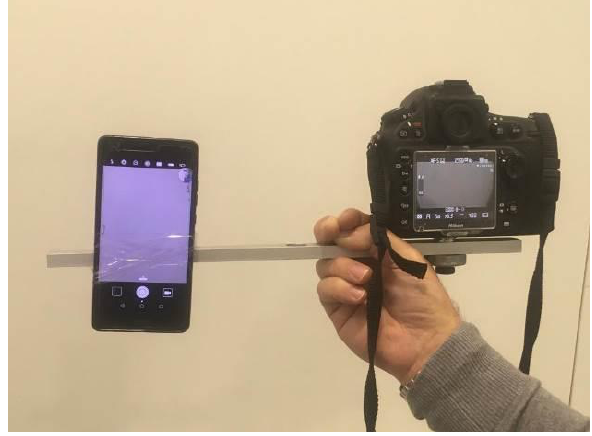
Figure 3. The handcrafted photogrammetric system used for the survey.